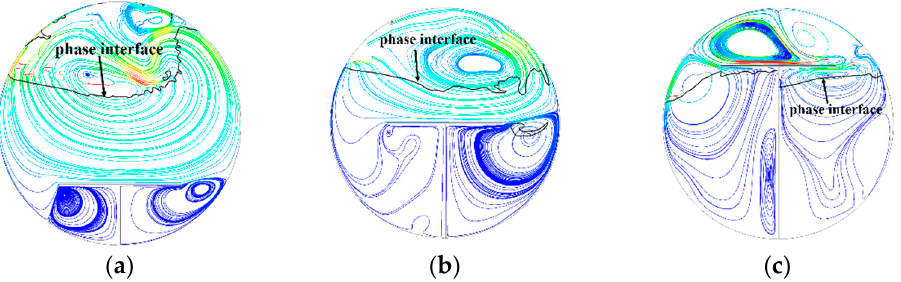
Figure 18. Flow diagram of liquid velocity (LR = 70%, t = 1 s). ( a ) baffle with HR = 0.25; ( b ) baffle with HR = 0.5; ( c ) baffle with HR = 0.75.